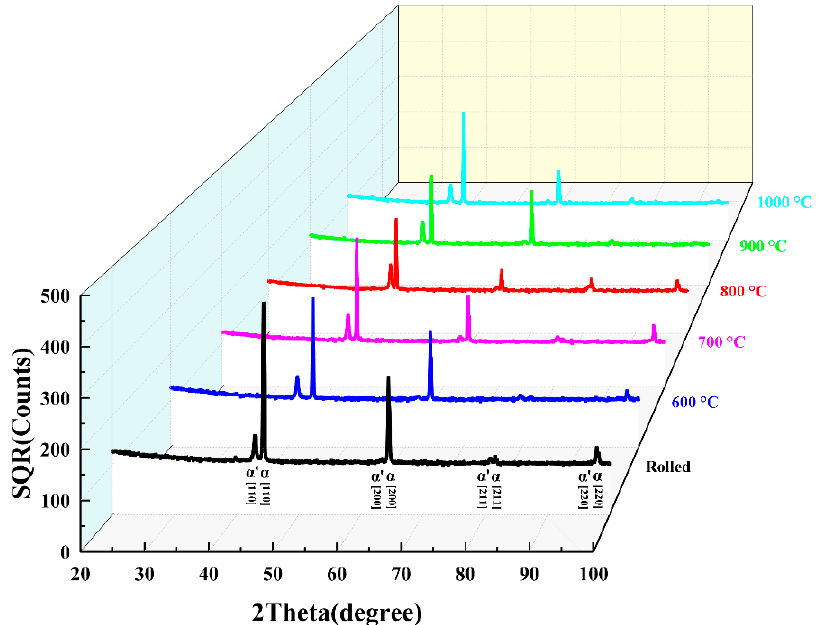
Figure 2. XRD profiles of the rolled and heat-treated Fe-25Cr-5Al-RE wire rod. The letters α and α (cid:48) Figure 2. XRD pro fi les of the rolled and heat-treated Fe-25Cr-5Al-RE wire rod. The le tt ers α and α′ denote ferrite and chromium, denote ferrite and chromium, respectively.